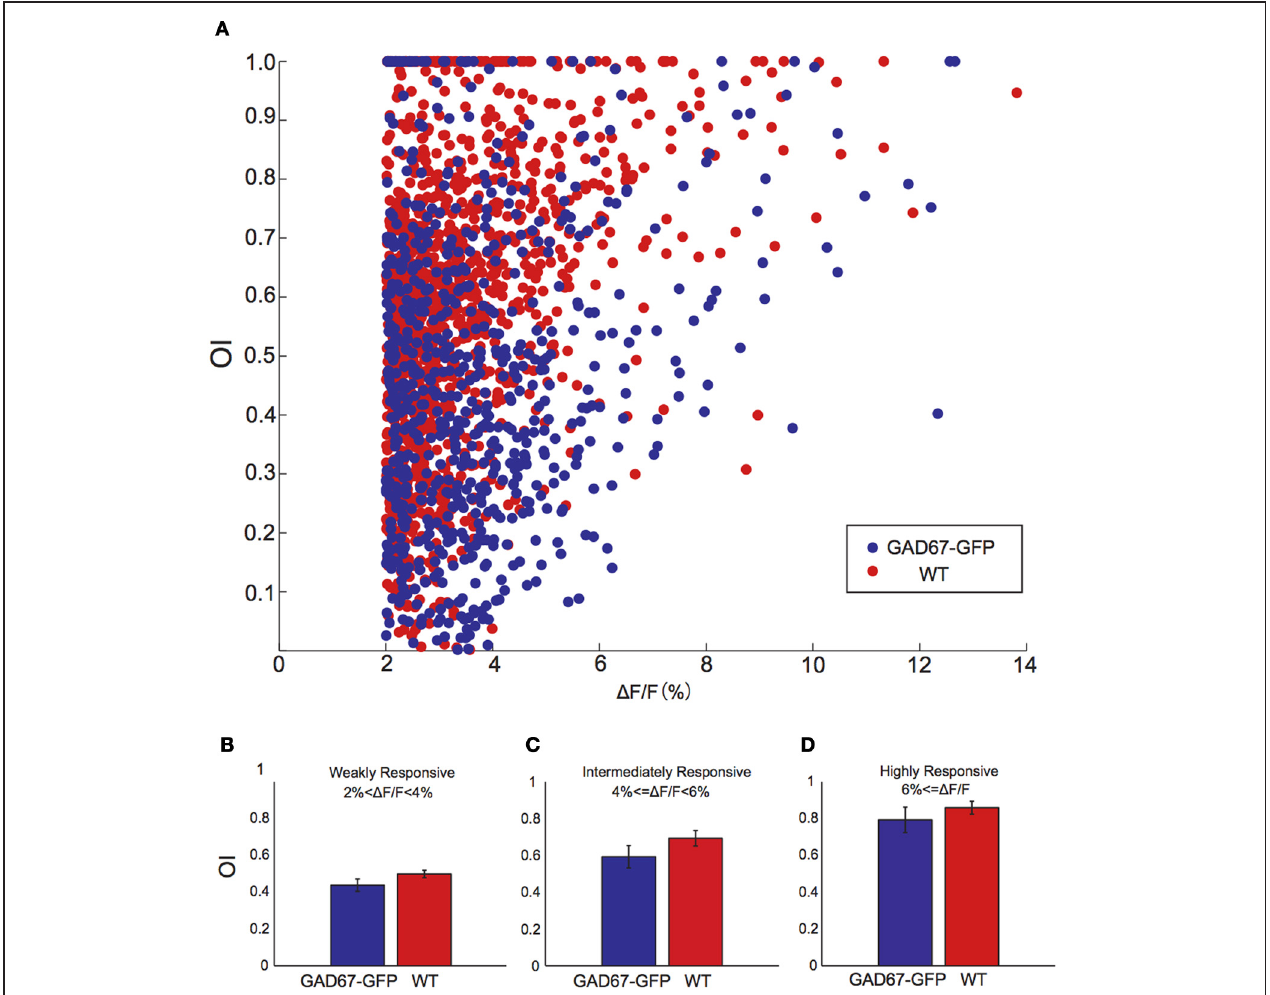
FIGURE 4 | Therelationship between response amplitude andorientation selectivity. (A) Scatter plot of the relationship between response amplitude and orientation selectivity for all responsive neurons from GAD-67GFP mice